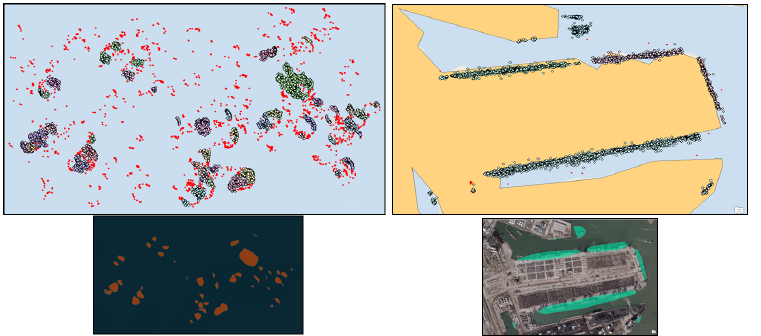
Figure 4. Anchorage regions ( left ) and containerized berth regions ( right ) outside and inside the port of Rotterdam. Points represent the vessel trajectory instances every hour. Point clusters may inform about the boundaries of each zone (bottom). In addition, the shape, the duration of visits, number of unique vessels, and vessel types within each region can inform its